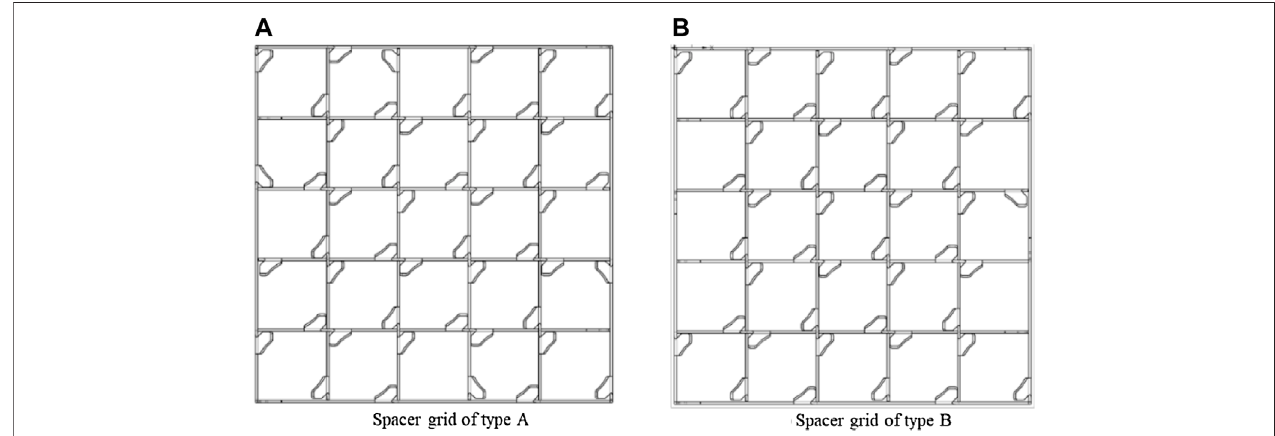
FIGURE 8 | Structure of the spacer grids (A) and (B)